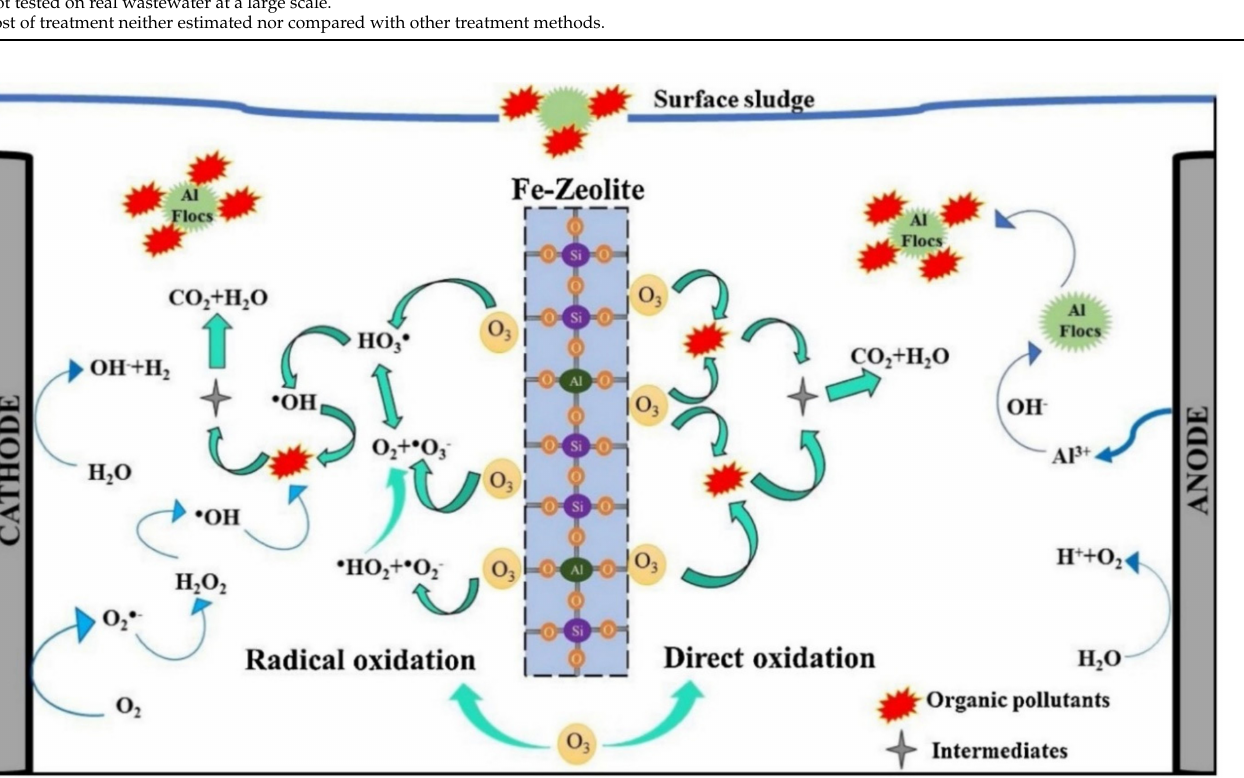
Figure 5. Mechanism for the synergic electro-flocculation–catalytic ozonation process for pharmaceu- tical wastewater treatment. Reprinted with permission from Ref.